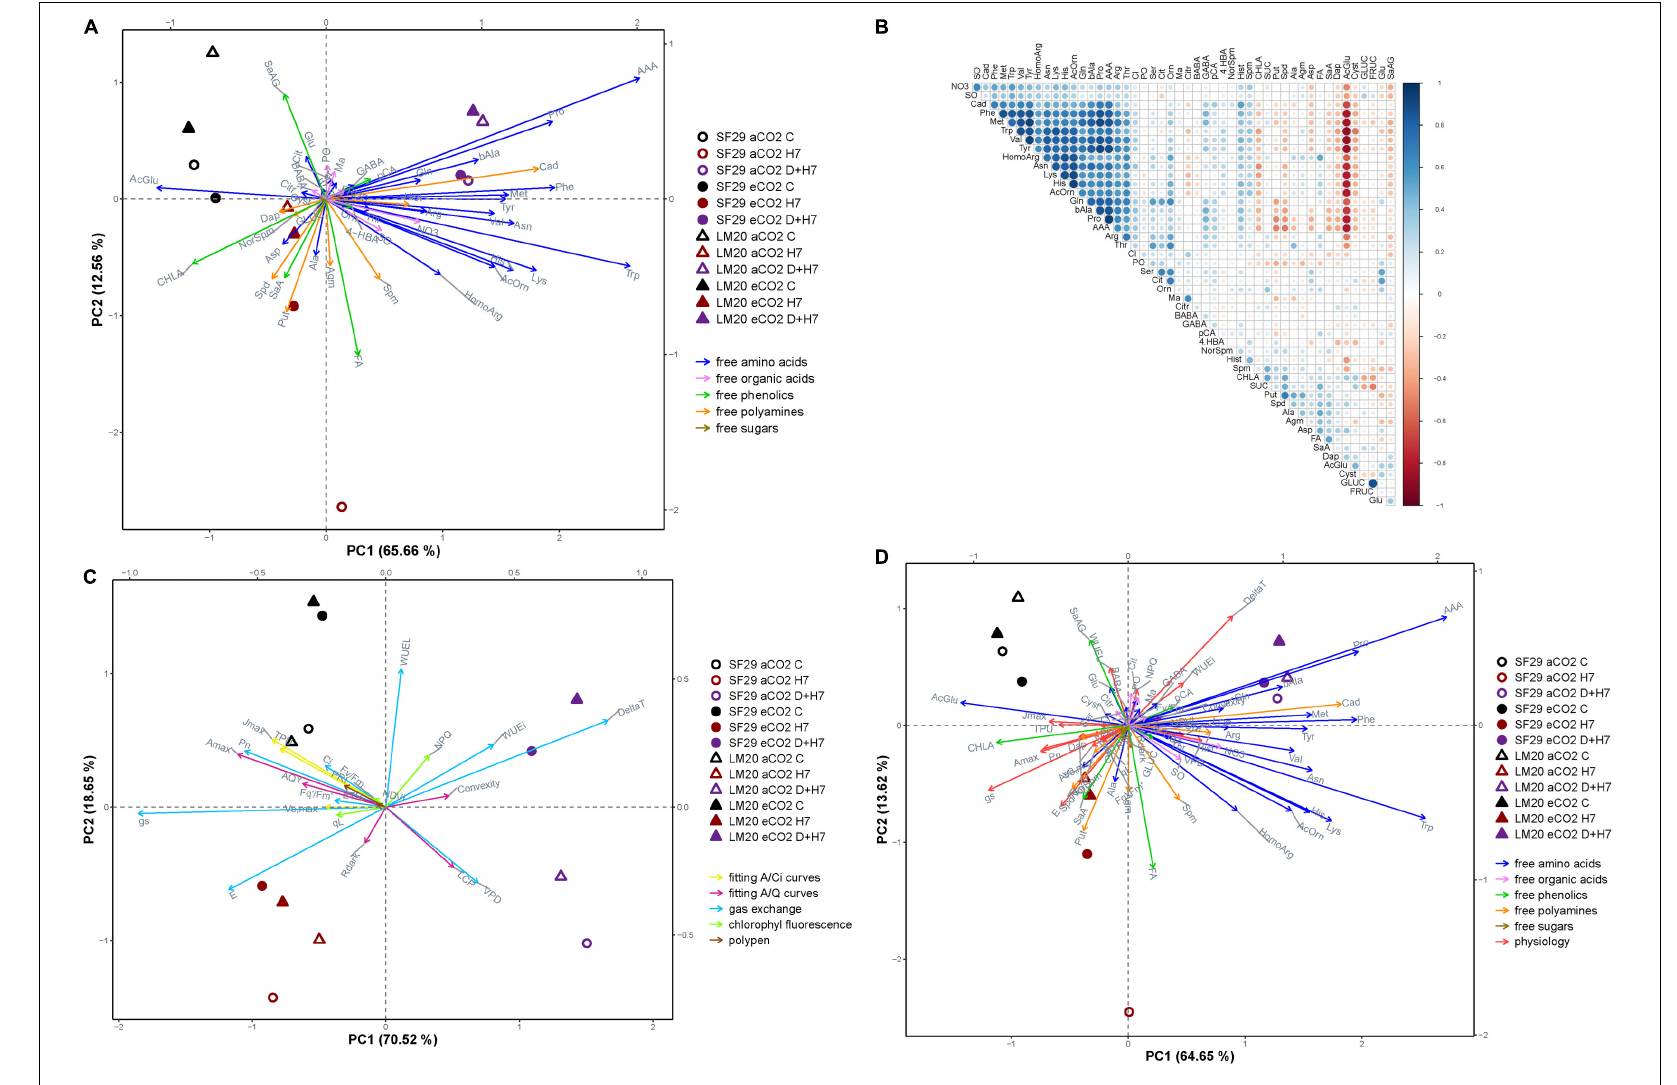
FIGURE 4 | Multivariate statistical analyses of primary and secondary metabolites and plant physiology at the anthesis stage. (A) Principal component (PC) analysis of the changes in primary and secondary metabolites; free amino acids, organic acids, phenolics, free polyamines, and carbohydrates represented in blue, pink, green, orange, and brown arrows, respectively, (B) correlation matrix among all metabolites, in which the size and intensity of blue (positive) and red (negative) circles correlated with the Pearson’s square-R correlation number, (C) PC analysis of the changes in the physiological parameters, and (D) PC analysis of the metabolites and physiological parameters together in heat-sensitive (SF29) and heat-tolerant (LM20) genotypes grown under control conditions (C), heat stress at Day 4 (H4), at Day 7 (H7), and combined heat stress and drought at Day 7 (D + H7) at ambient CO 2 (aCO 2 ) or elevated CO 2 (eCO 2 ). The X -axis and Y -axis represent the PC1 and PC2, respectively, with the percentage of the total variance of the